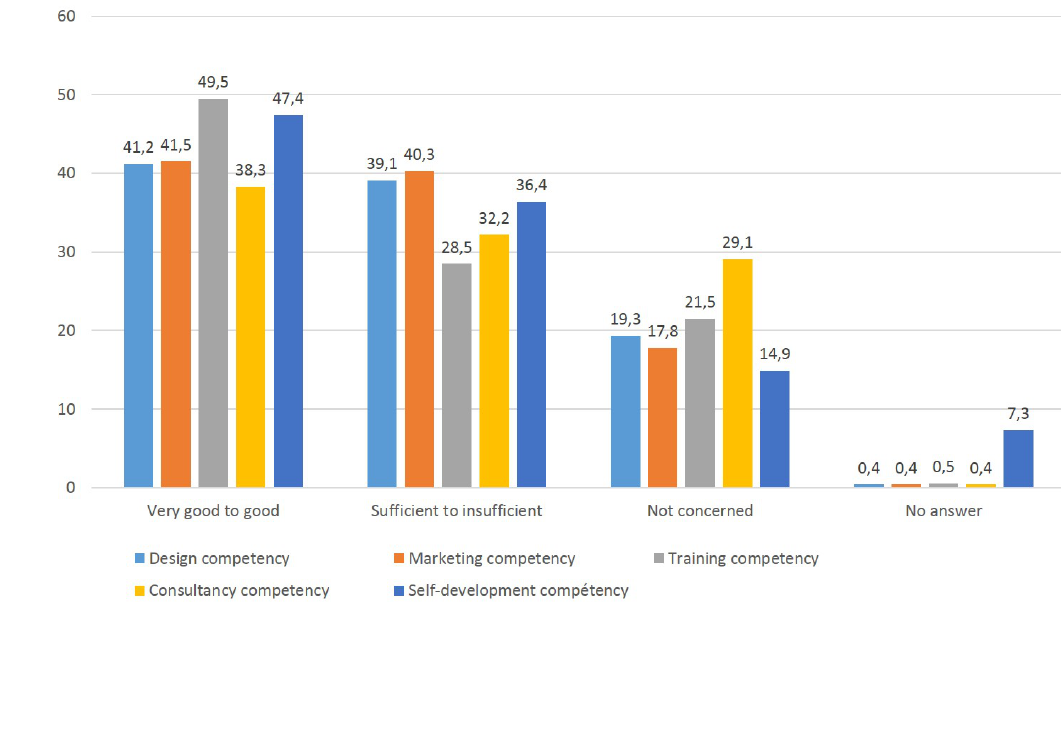
Figure 3 : Self-evaluation of mastery level by respondents In sum, whatever the competencies segment may be, the level of mastery is considered to be from ‘very good to good’ for 38 to 50 % respondents, with the highest percentage for the core ‘Training’ competencies. These competencies concern the knowledge of tools and pedagogical methods, the conception of pedagogic tools adapted to various market segments, the development of pedagogical programs. It should be noted that nearly one third of the respondents declares itself not concerned by the core ‘Consultancy’ competencies, which notably includes the accompaniment of a salaried person to define and implement a professional project, and identifying the required skills for